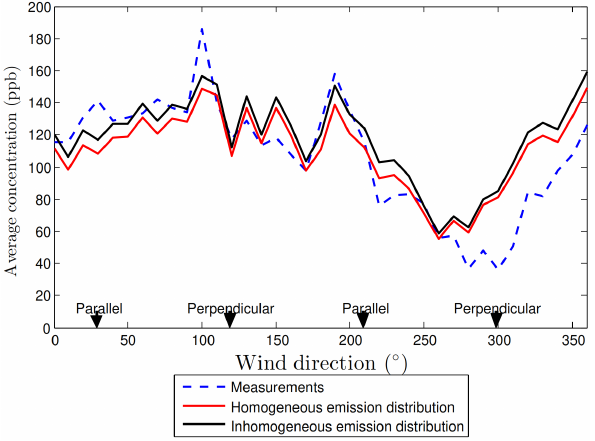
Figure 12. Average NO x concentrations as a function of wind di- rection for the morning rush hour 07:00–09:00LT. for both 2003 and